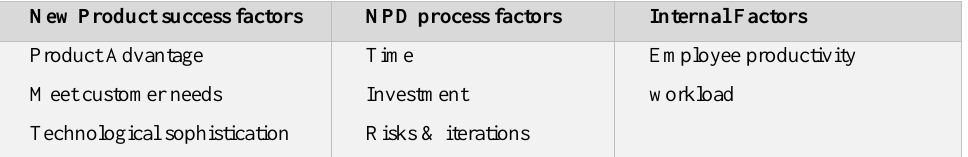
Table 1: Factors for